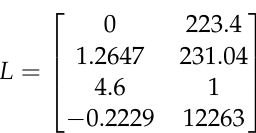
Figure 10. ( a ) Tracking error 𝐸 3𝑓 , ( b ) tracking error 𝐸 4 . Dashed black line — 𝑘 1 = 𝑘 2 = 𝑘 3 = 𝑘 4 = 15 , solid red line — 𝑘 1 = 𝑘 2 = 𝑘 3 = 𝑘 4 = 5 . Figure 11. ( a ) Tracking error 𝑥 1𝑑 − 𝑥 1 , ( b ) tracking error 𝑥̇ 1𝑑 − 𝑥 2 . Dashed black line — 𝑘 1 = 𝑘 2 = 𝑘 3 = 𝑘 4 = 5 , solid red line — 𝑘 1 = 𝑘 2 = 𝑘 3 = 𝑘 4 = 15 .